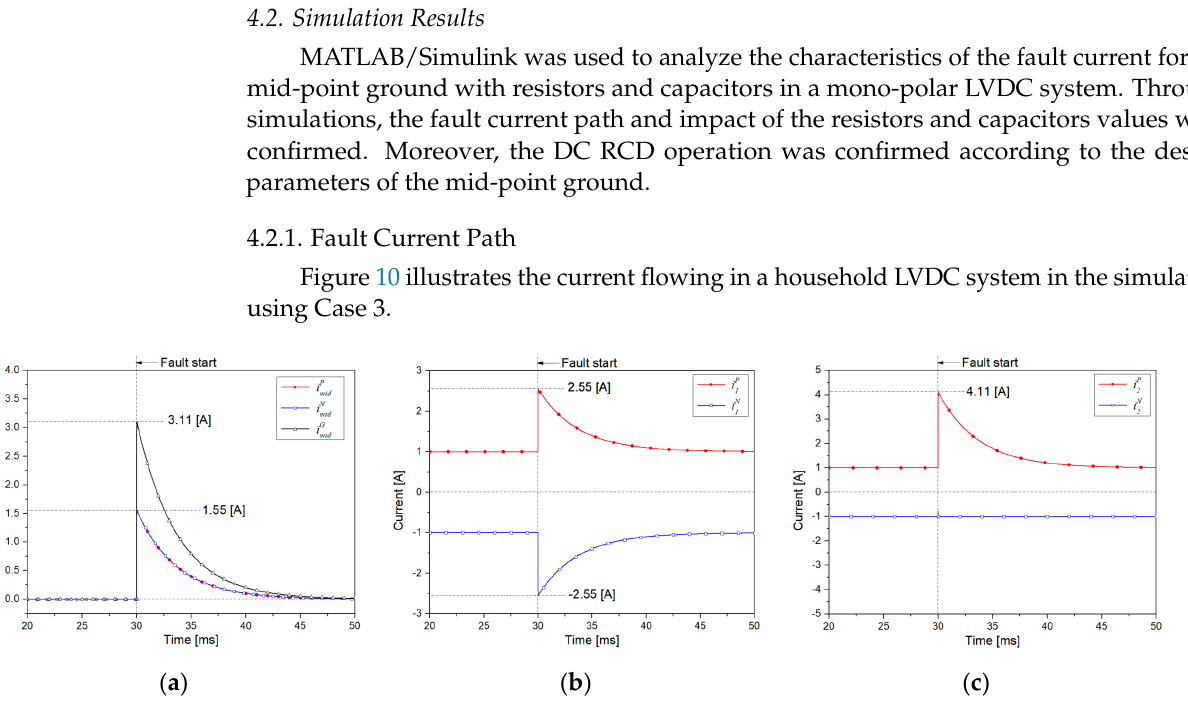
Figure 10. Waveforms of the discharge current of the simulation circuit using the mid ‐ point ground system: ( a ) Capacitor discharge current in the mid ‐ point ground system; ( b ) Current in front of the ground system; ( c ) Current in the back of the ground system.